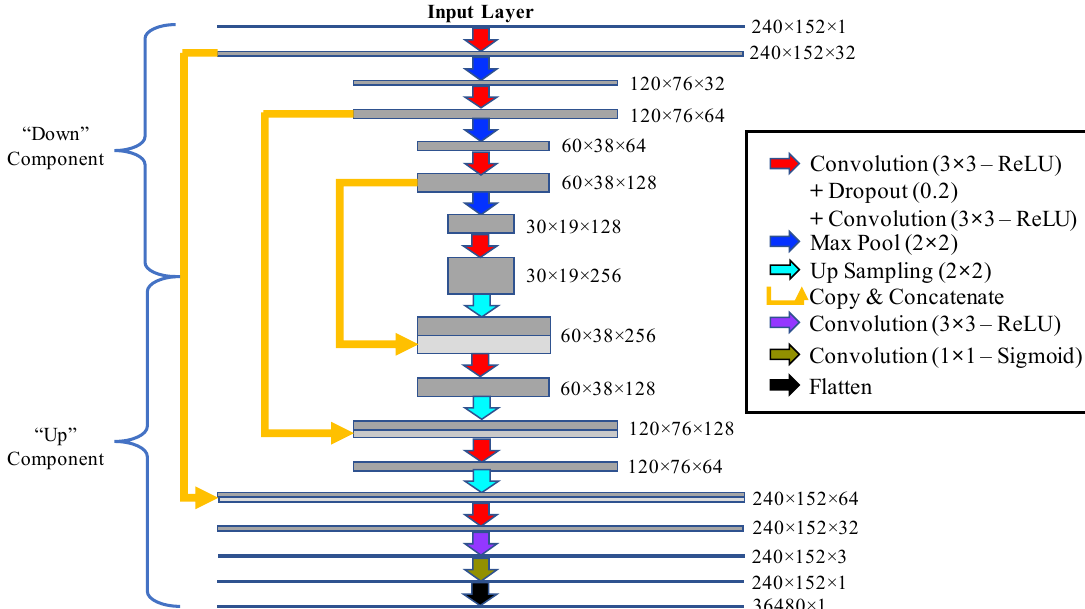
Figure 2. Architecture of the neural network. The length and width of each layer correspond to the pixel dimensions and the number of feature channels (bands) respectively. Convolutional and pooling kernel sizes and upsampling dimensions indicated in parentheses (e.g., 3 × 3 for convolutional layers and 2 × 2 for pooling). Dropout ratio indicated in parentheses (0.2). The activation function is also stated for convolutional layers (ReLU=REctified Linear Unit, and